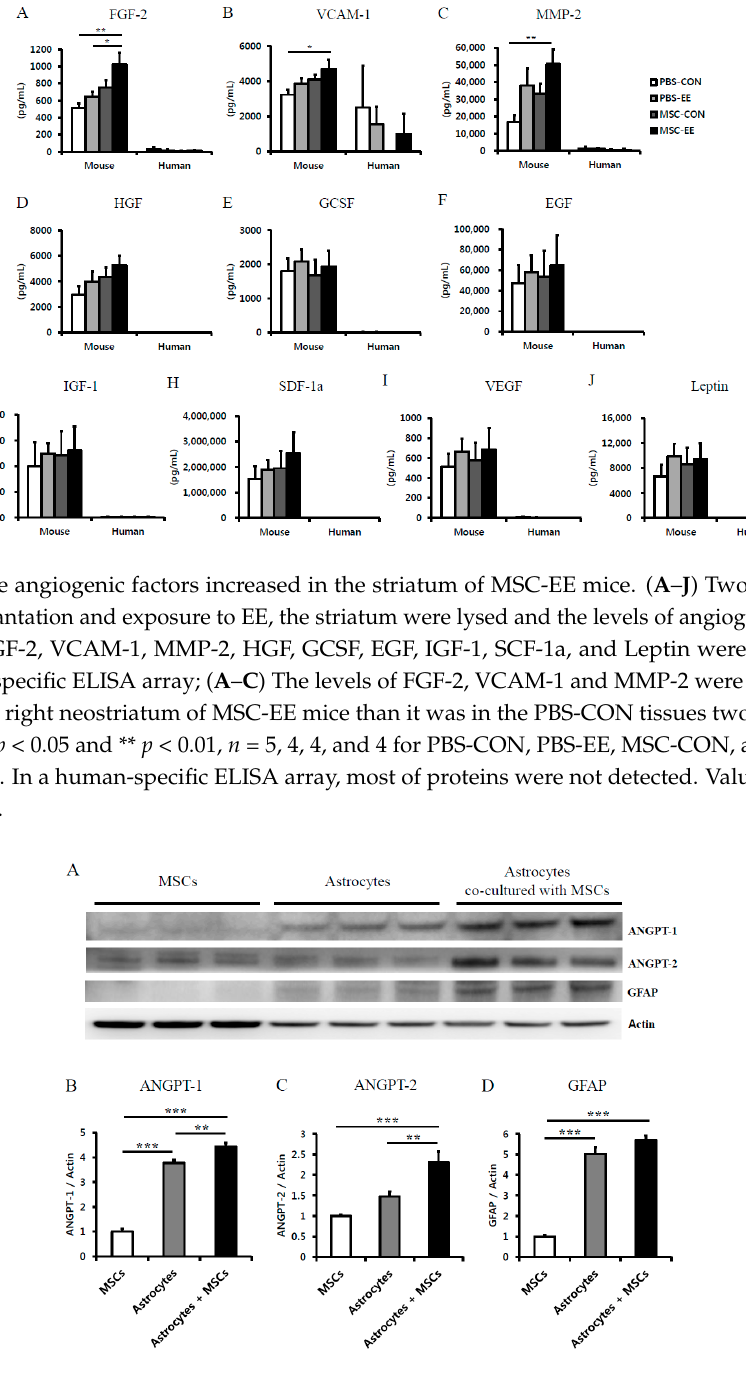
blotting. As a result, the astrocytes co-cultured with MSCs and astrocytes cultured alone increased the expression of GFAP (5.70 ± 0.20 and 5.02 ± 0.33, respectively, p < 0.001) compared to MSCs cultured alone (1.00 ± 0.08, respectively).